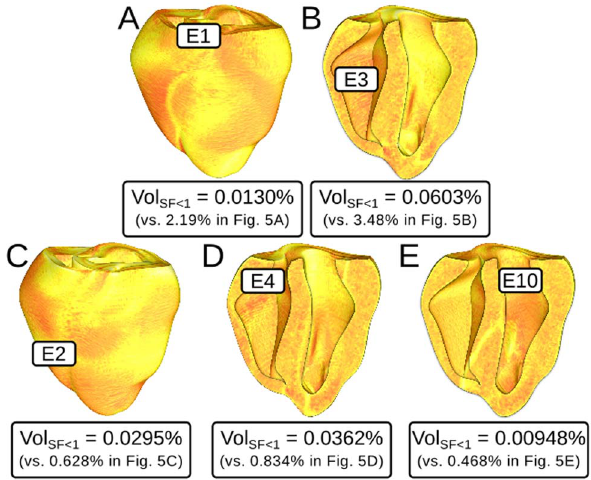
Figure 6. Maps of SF for propagation during the first excitation cycle following ectopic stimulation from several different sites in simulations with 40% of normal I Na (same scale as Fig. 5); location and timing of all 5 PVCs is identical to Fig. 5. None of the PVCs analyzed here induced reentry. Labels show quantitative comparison to the corresponding SF maps in Fig. 5. Vol SF , 1 : percent volume of tissue in the ventricles with SF , 1. Comparison of Vol SF , 1 to the corresponding values in the simulations with 30% of normal I Na shown in parentheses.